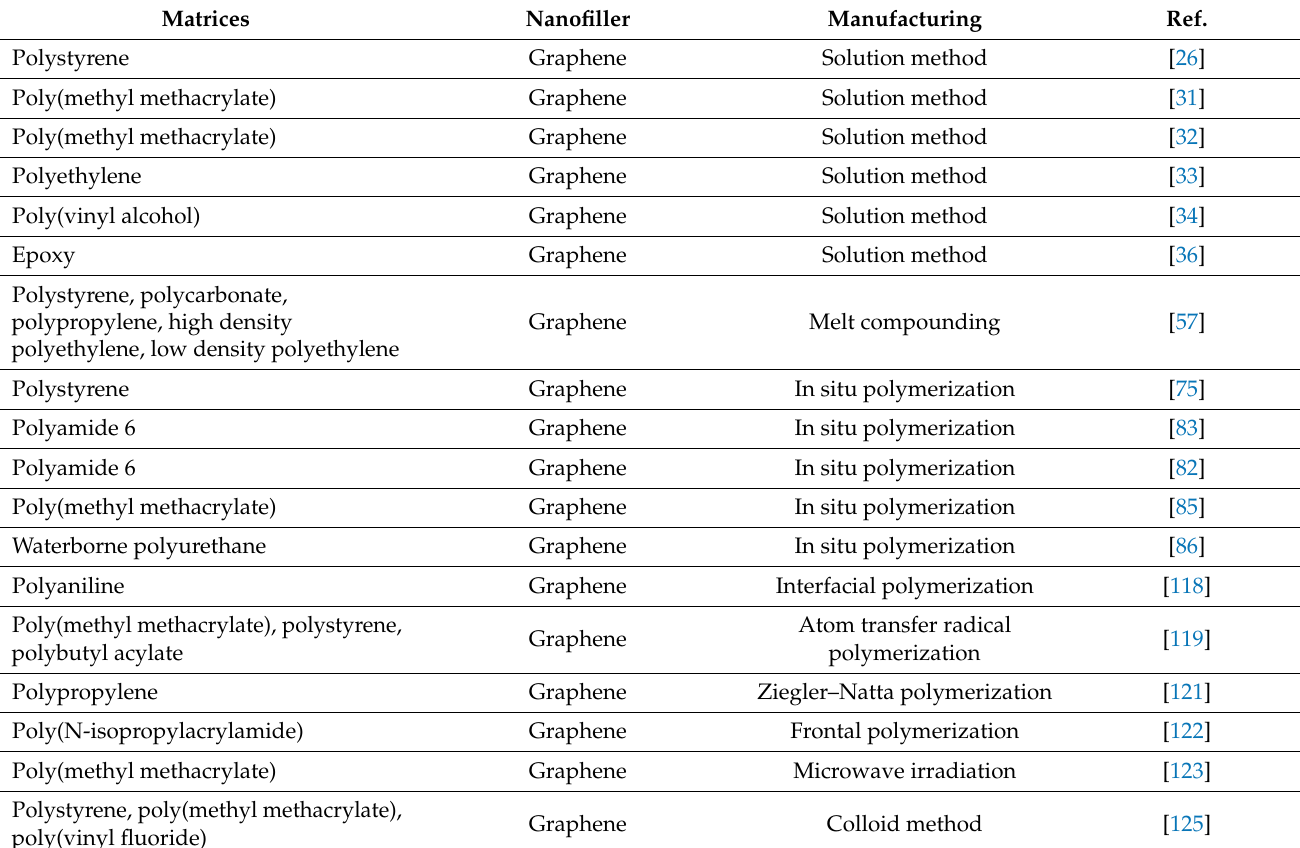
Table 2. Specifications of polymer/graphene nanocomposites using various manufacturing